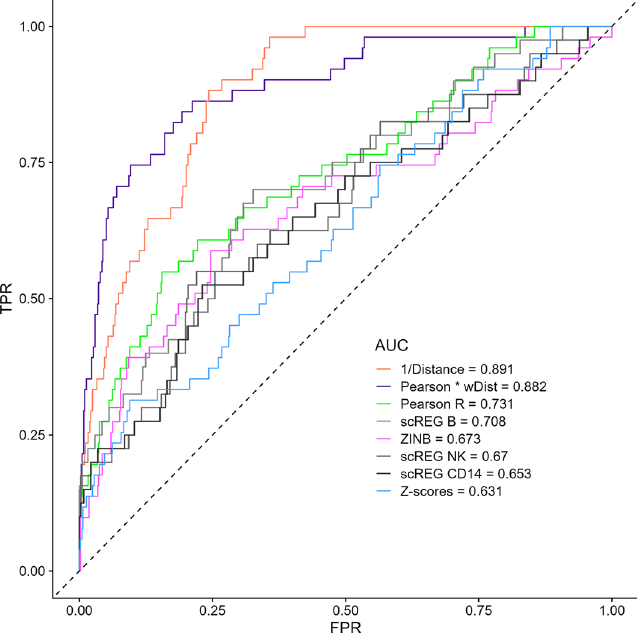
Figure 4. Physical distance and the Pearson R coefficient best capture cCRE-gene pairs identified by CRISPR perturbations. We identified 644 CRISPR-validated cCRE-gene pairs that had corresponding links (defined using |Pearson R|> 0.01) in the PBMC multiomic dataset. Distance-alone or distance-weighted Pearson R coefficients are the best predictors, with the Z-score method (implemented in Signac) performing worst. ZINB; zero-inflated negative binomial, wDist; weighted distance (e (−distance/200 kb) ), TPR, true positive rate; FPR, false positive